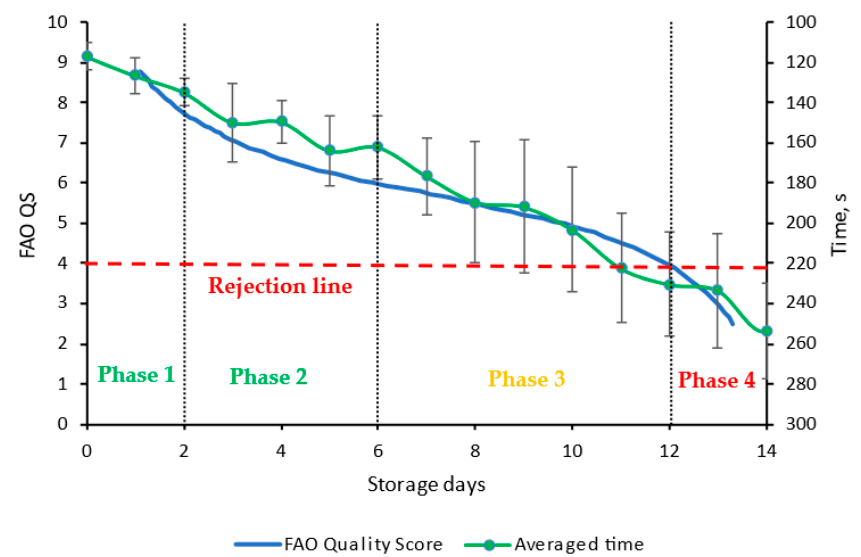
Figure 10. Comparison of UN FAO Quality Score curve and mean values of Time obtained with a number of fish and meat samples stored aerobically at +2–4 °C. Phase 1: The fish is very fresh and has a sweet, algal, and delicate taste. The taste can be very slightly metallic; Phase 2: There is a loss of the characteristic odor and taste. The flesh becomes neutral but has no off-flavors. The texture is still pleasant; Phase 3: There is sign of spoilage and a range of volatile, unpleasant-smelling substances is produced, depending on the fish species and type of spoilage (aerobic or anaerobic); Phase 4: The fish can be characterized as spoiled and putrid [52].